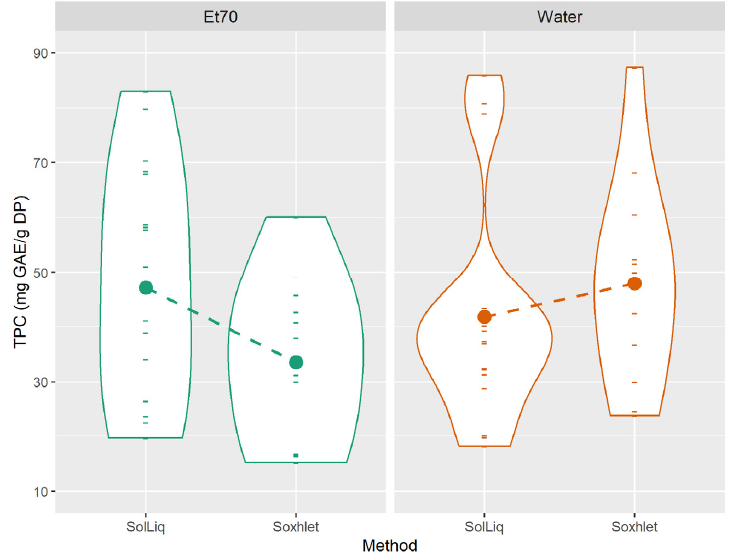
Figure 5. Interaction plot “method × solvent” on the total phenolic content of plant